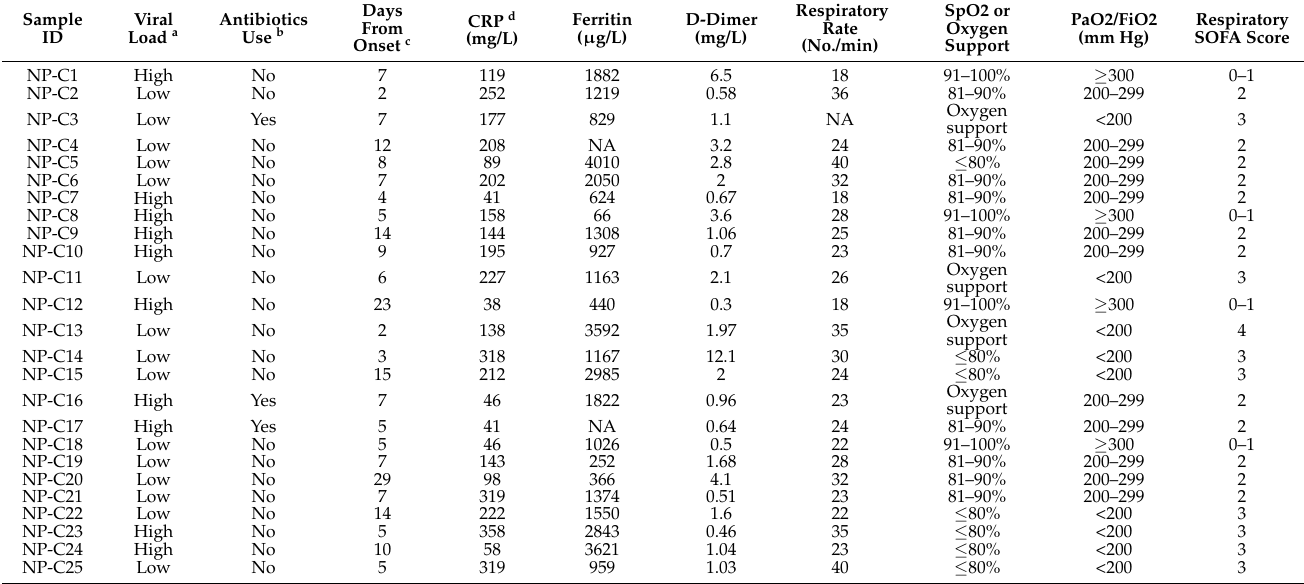
Table 1. Characteristics of 37 COVID-19 patients #